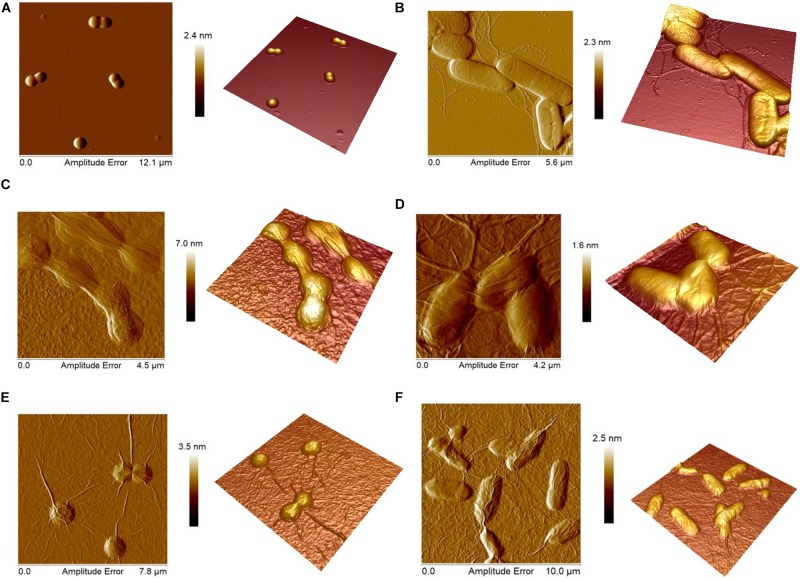
Atomic force microscopy images showing a 2D amplitude image at left and height 3D image at right. (A)
Staphylococcus aureus. (B)
Escherichia coli. (C)
S. aureus-GO (300 μg ml–1). (D)
E. coli-GO (1.13 mg ml–1). (E)
S. aureus-nGO (446.3 μg ml–1). (F)
E. coli-nGO (535.5 μg ml–1). All solutions were incubated with deionized water for 45 min threshold dose analyses for phototoxicity.